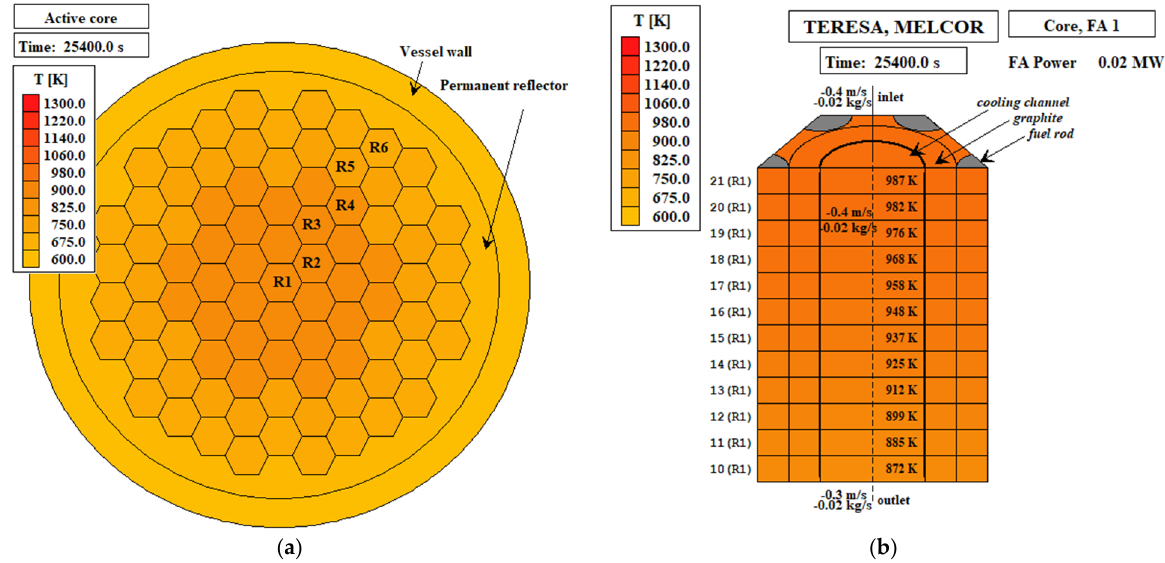
Figure 8. Results of PLOFC scenario, at t = 25 400 s: ( a ) temperature of the fuel at the bottom of the core; ( b ) temperature of cooling channels in the central block (BOL case).